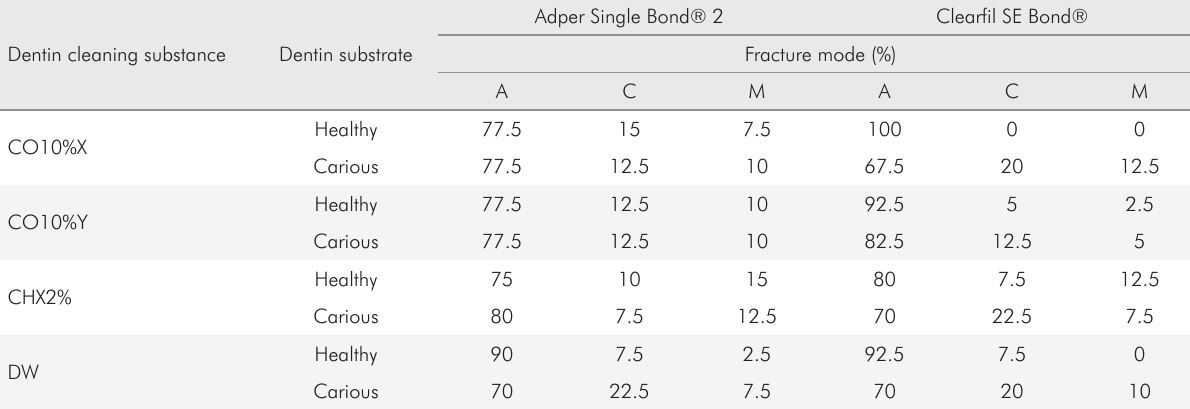
Table 5. Fracture mode distribution according to healthy or carious substrate, test substance for dentin cleaning, and adhesive system. Dentin cleaning